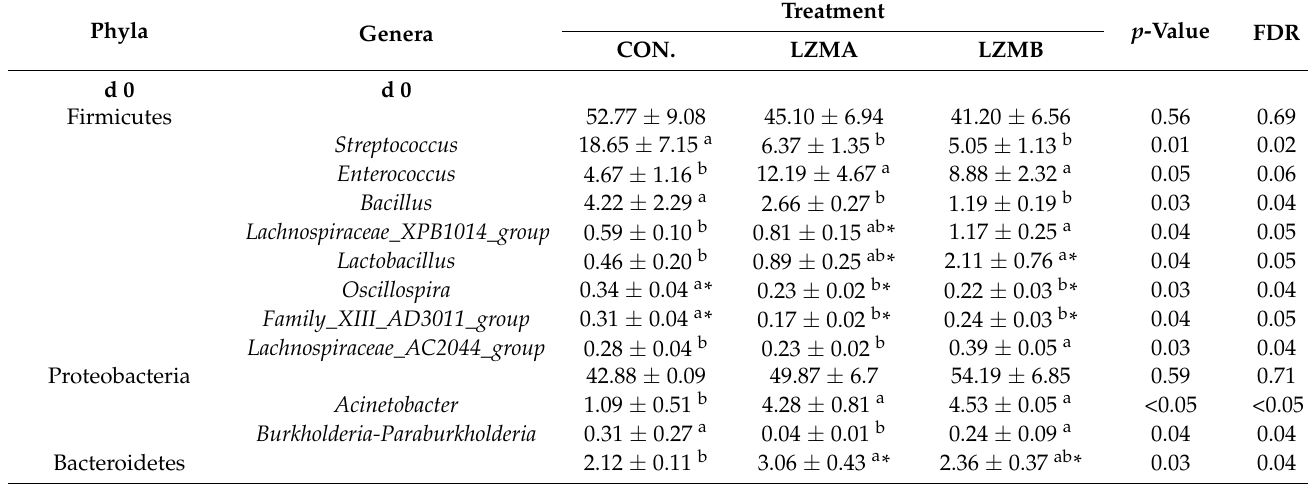
Table 2. The relative abundances at phyla level (%, >0.1% in at least one sample) and genera level (%, >0.3% in at least one sample, show only significant differences here) in vaginal sample of feeding sows with